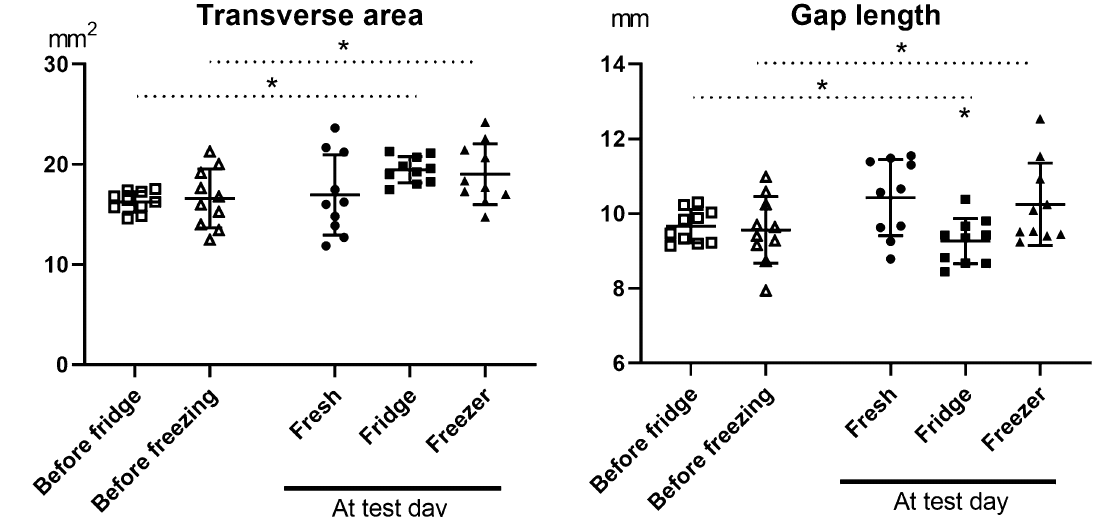
Figure 1. Transverse area and gap length measurements from experiment 2. Measurements were done before samples were stored in the fridge or freezer and after storage, at the mechanical testing day (n = 10). The line represents the mean and the bars SD. Image created using GraphPad Prism software, version 8. https ://www. graph pad.com/scien tific -softw are/prism